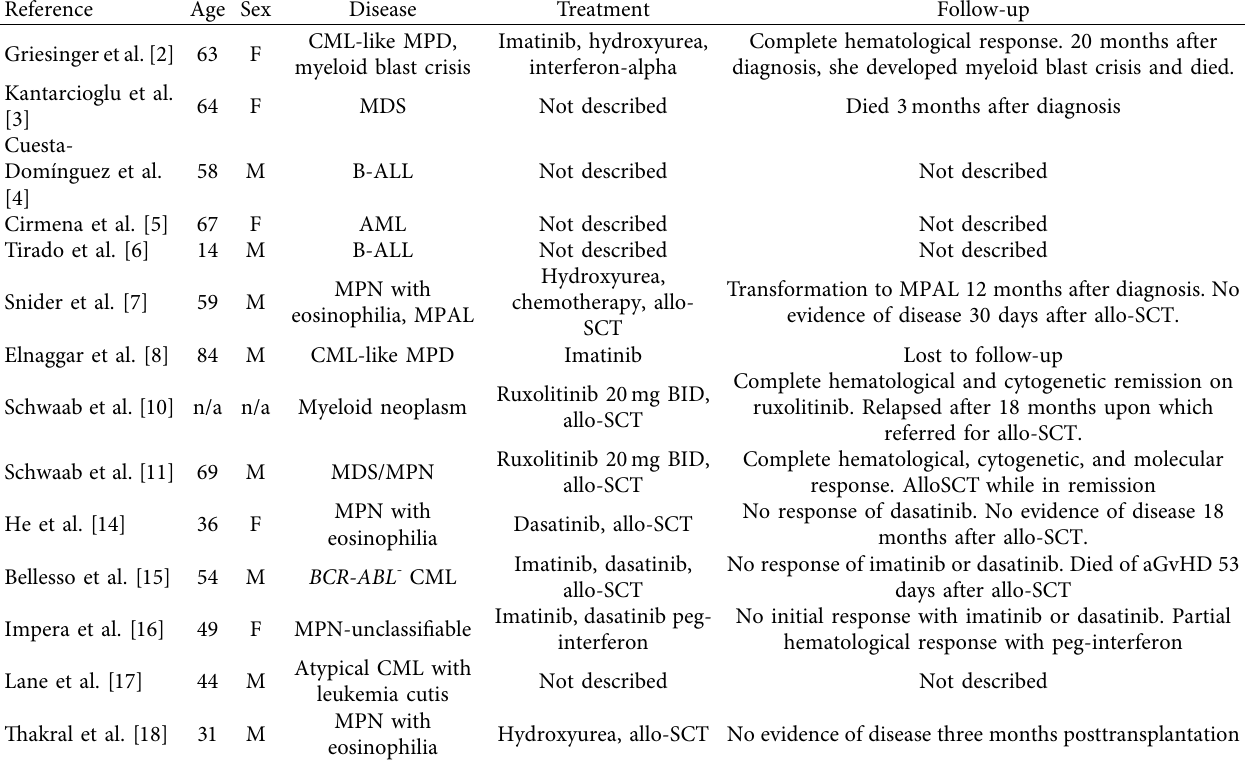
Table 1: Summary of the literature regarding described phenotype, treatment, and response duration of patients with a BCR-JAK2 fusion. Reference Age Sex Disease Treatment Follow-up CML-like MPD, Imatinib, hydroxyurea, Complete hematological response. 20 months after F myeloid blast crisis interferon-alpha diagnosis, she developed myeloid blast crisis and died.